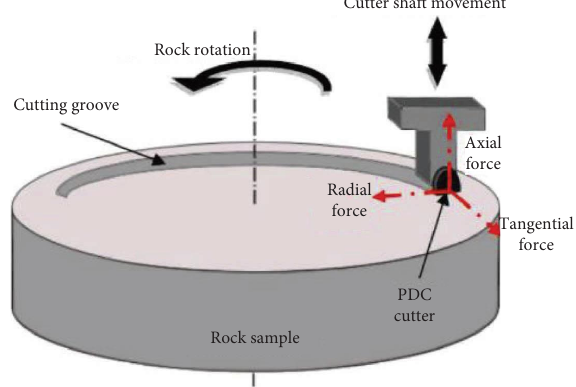
Figure 2: Schematic diagram of the single cutter test. [23].